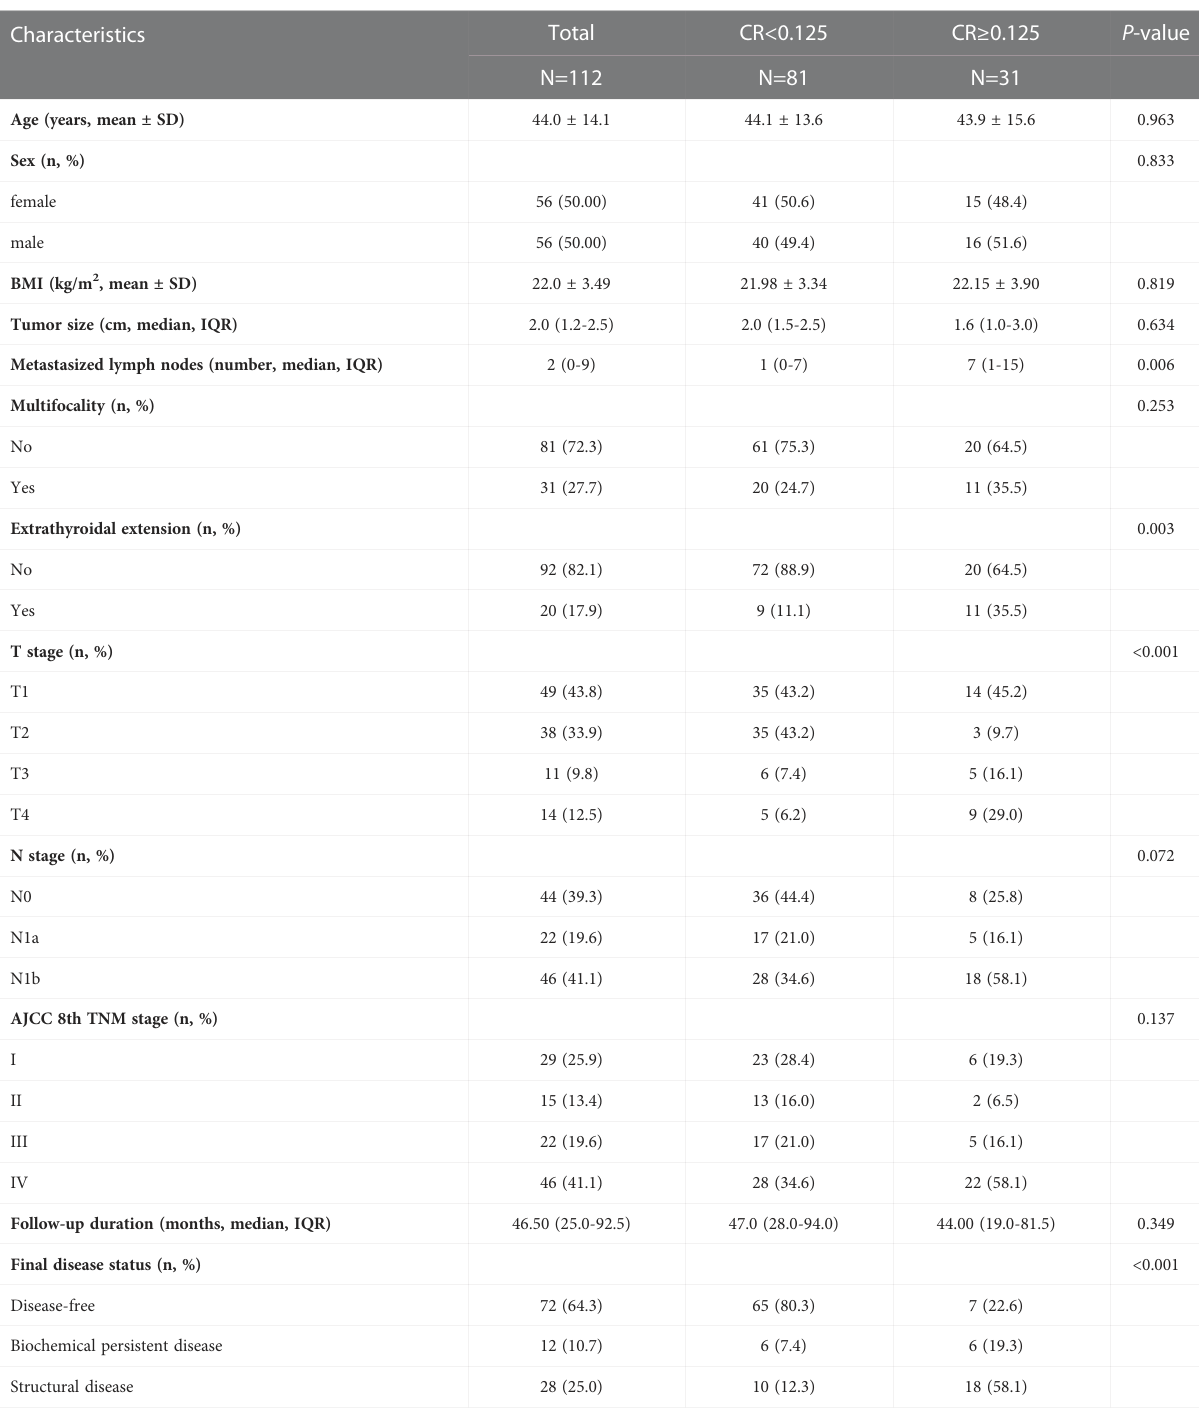
TABLE 1 Characteristics of patients classi fi ed according to the